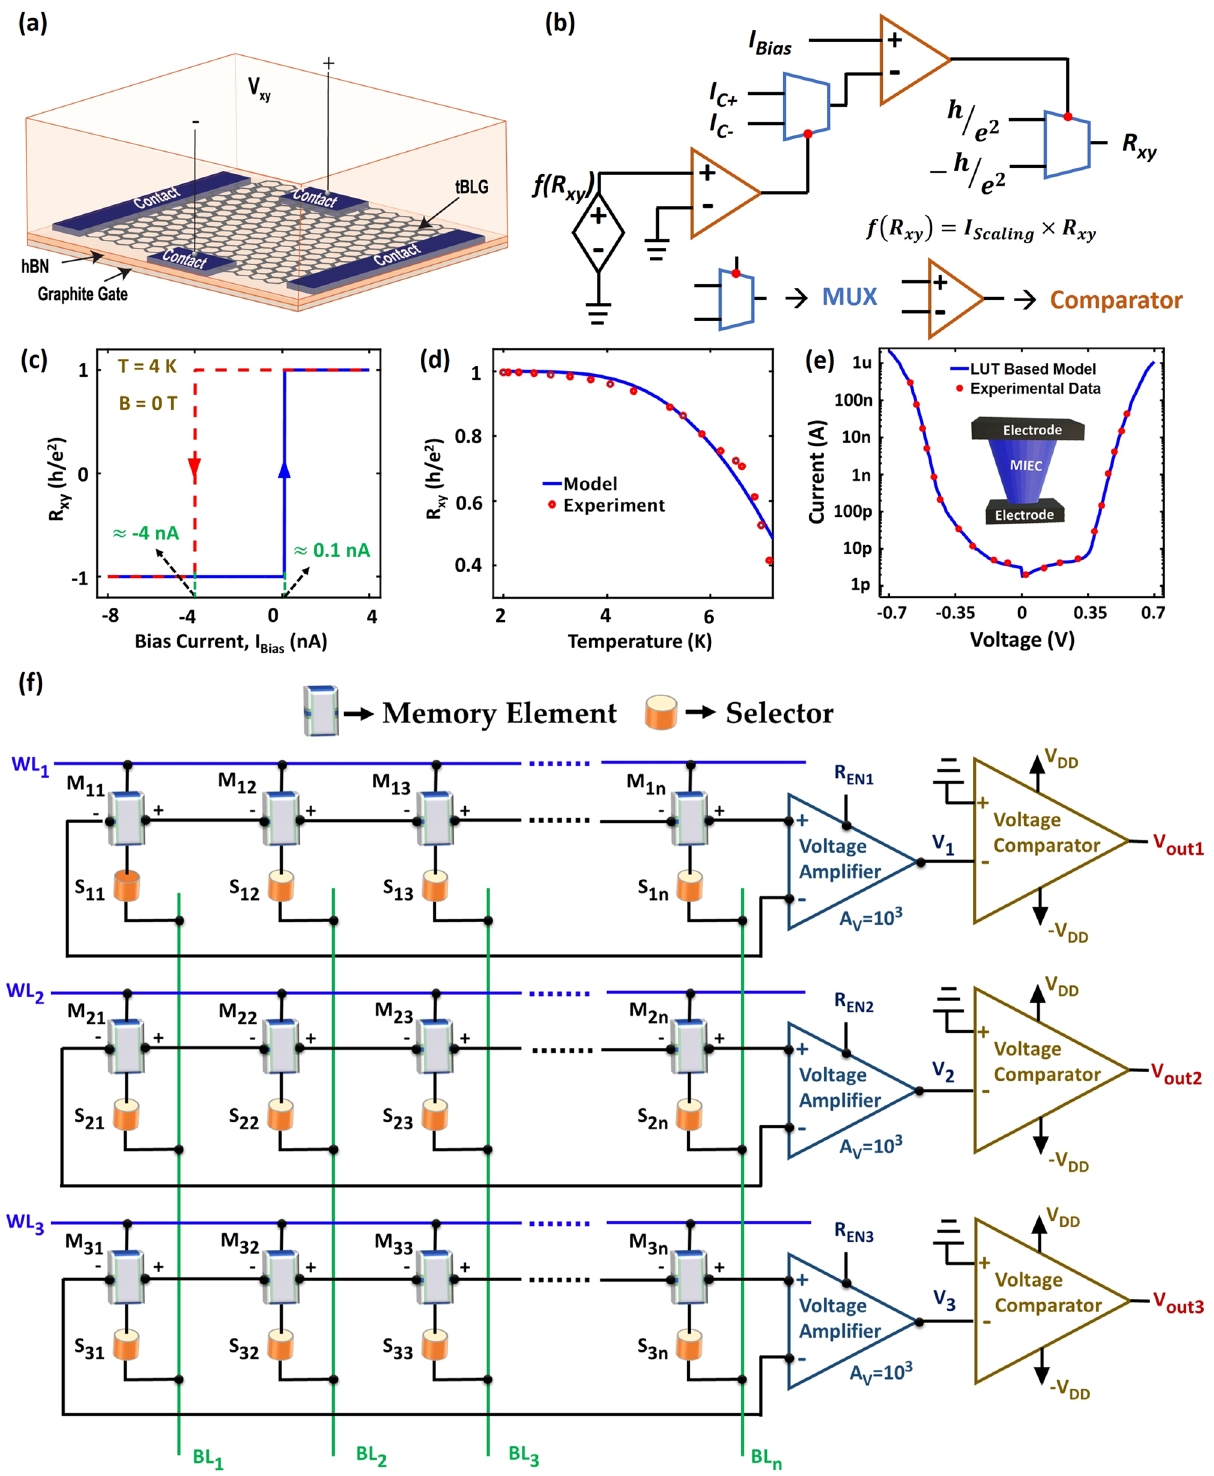
Figure 3. Design of the 3D cross-point memory array structure using a tBLG moiré heterostructure as a memory element and mixed-ionic-electronic-conduction based access device as selector. ( a ) Schematic of a tBLG moiré heterostructure where tBLG is encapsulated between flakes of hBN and a flake of few-layer graphite is used as gate. ( b ) Behavioral representation of our phenomenological model of the observed QAHE in the tBLG moiré heterostructure. ( c ) R xy data , plotted as a function of I Bias at T = 4 K and B = 0 T, exhibit current driven hysteretic switching. ( d ) Temperature dependence of R xy with an experimental matching. ( e ) I–V characteristics obtained from a look-up table (LUT) based model of the mixed-ionic-electronic-conduction (MIEC) based selector device. ( f ) Illustration of the overall memory array structure, custom-designed for the QAHE based memory